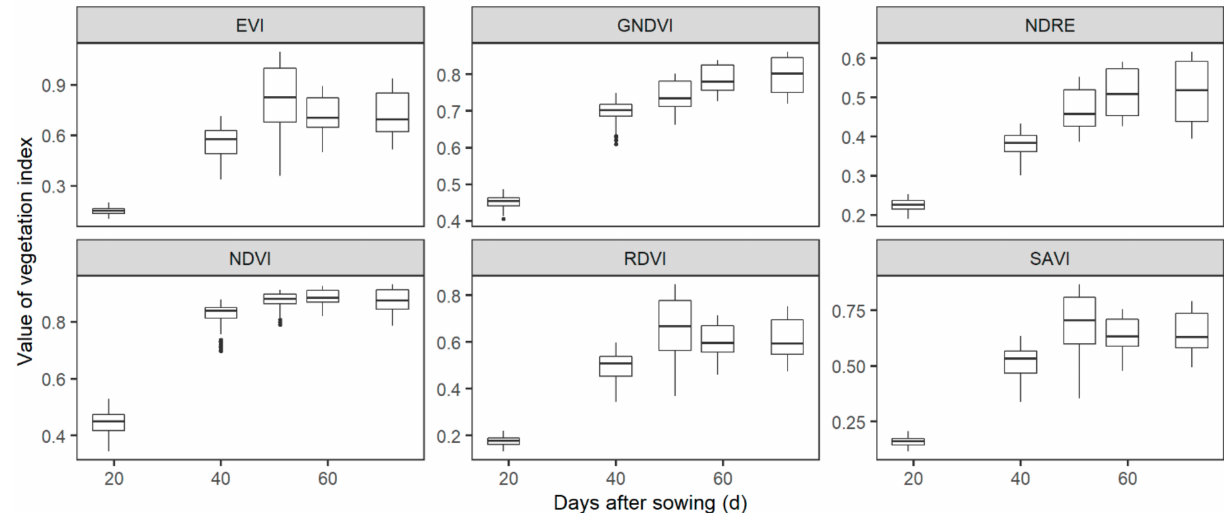
Figure 4. Dynamic changes of spectral indexes before wheat flowering. Spectral indexes were calculated from ortho-mosaics that were created from UAV-sensed multi-spectral images. Detailed information of indexes is listed in Table 1.